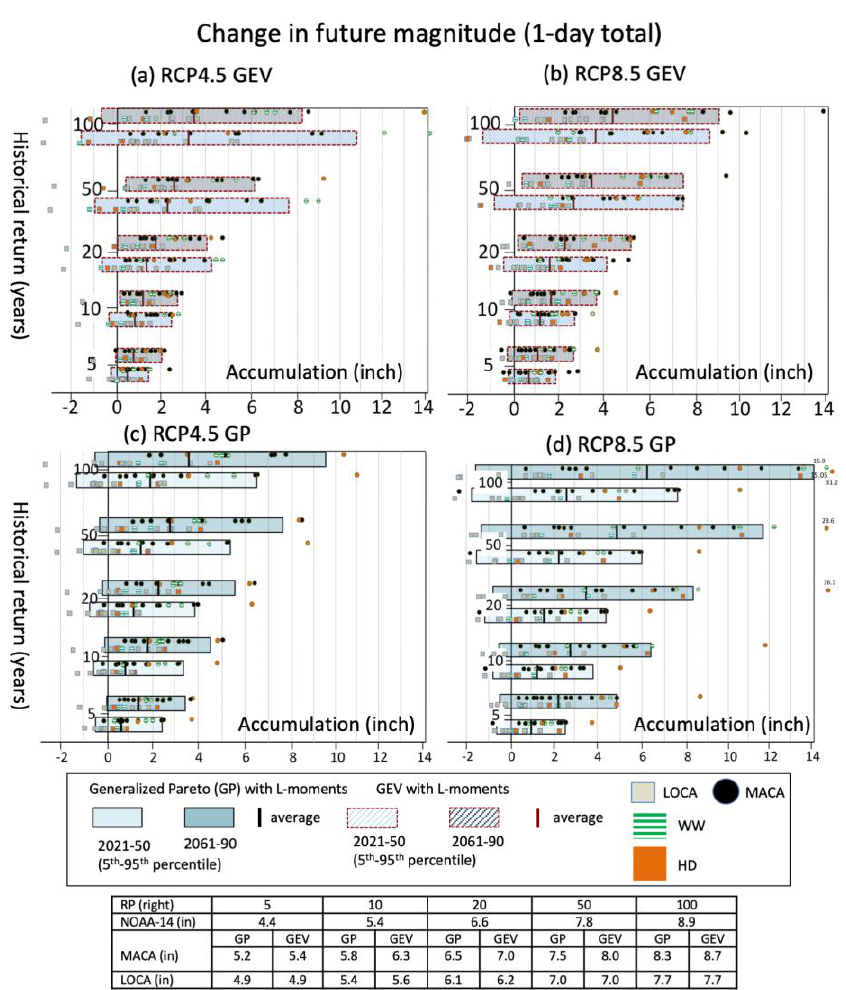
Figure 8. As Figure 7, although here showing the change in return-period magnitudes (inches). The calculated historical return-period amounts (inches) for daily precipitation (table at bottom) show results for the two different EVDs and the NOAA-14 Atlas (observation/historical dataset).